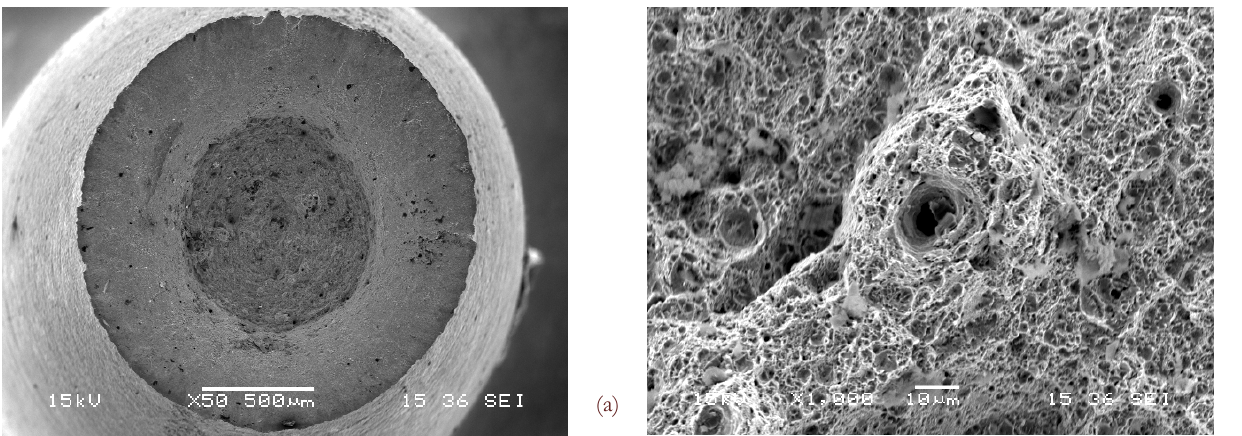
Figure 9: (a) Fracture surface for Maraging 250 specimen peak-aged at 535°C and (b) X1000 magnification for test in 3.5% NaCl aqueous solution with galvanic